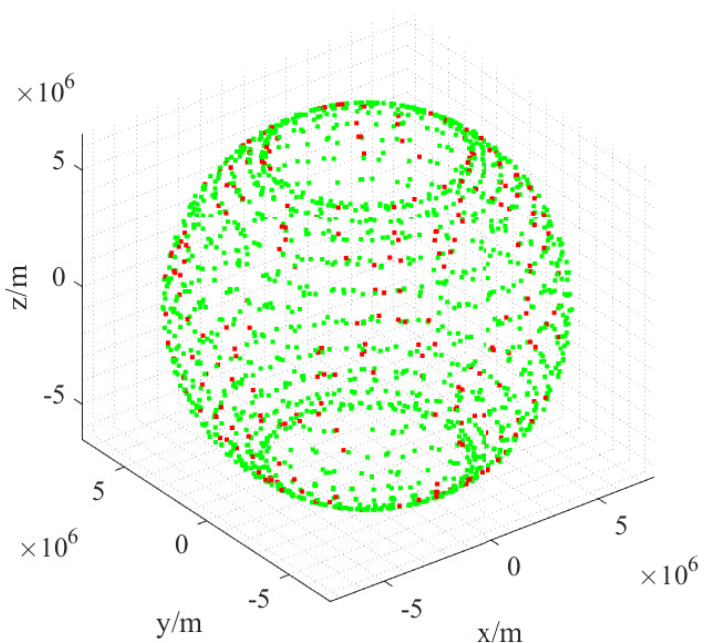
Figure 19. Initial distribution of the mega constellation. Red dots represent satellites that do not satisfy the continuous coverage constraint while green dots represent satellites that satisfy the continuous coverage